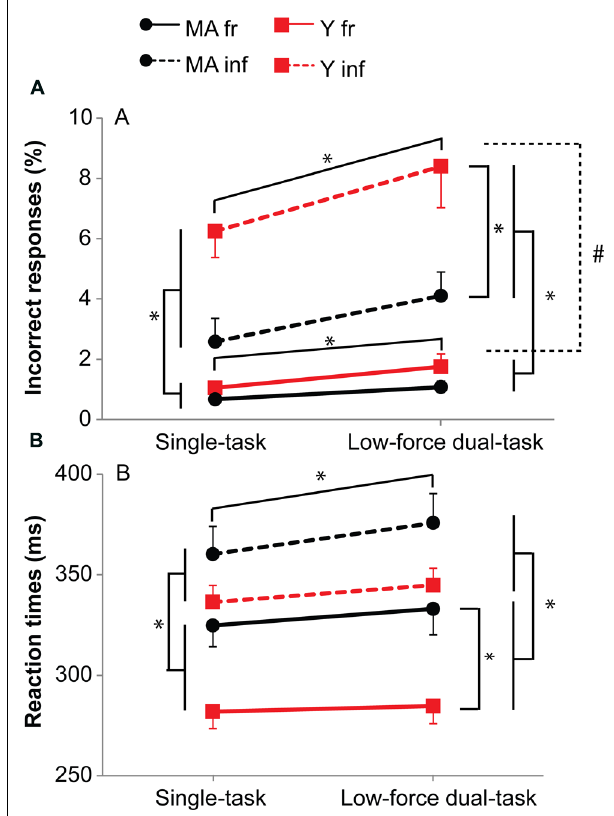
FIGURE 4 |Accuracy (A) and reaction times (B) for the single and 10%-dual-task (10% MVC). Black circles represent middle-aged subjects, red squares represent young subjects. Solid lines for frequent stimuli, dashed lines for infrequent stimuli. Error bars represent SE. * shows main effects, # shows interaction effects.The graphs shows the difference between the two age groups with respect to preparation, i.e., faster reaction times for the frequent stimuli, but larger number of errors for the infrequent stimuli especially for the young